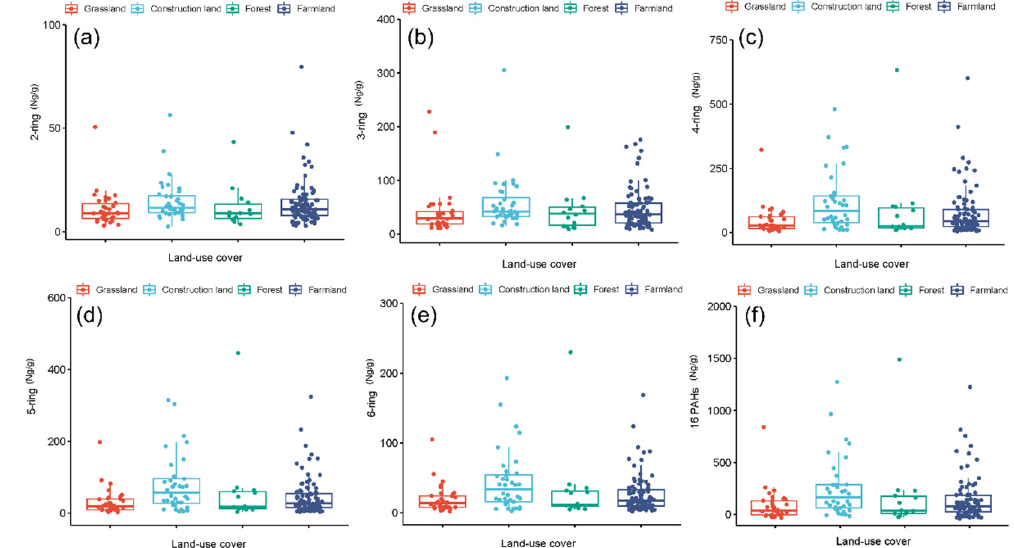
Figure 5. Boxplot of soil PAHs with different ring numbers ( a – e ) and ∑ 16 PAHs ( f ) under different land-use covers in Shanxi Province.